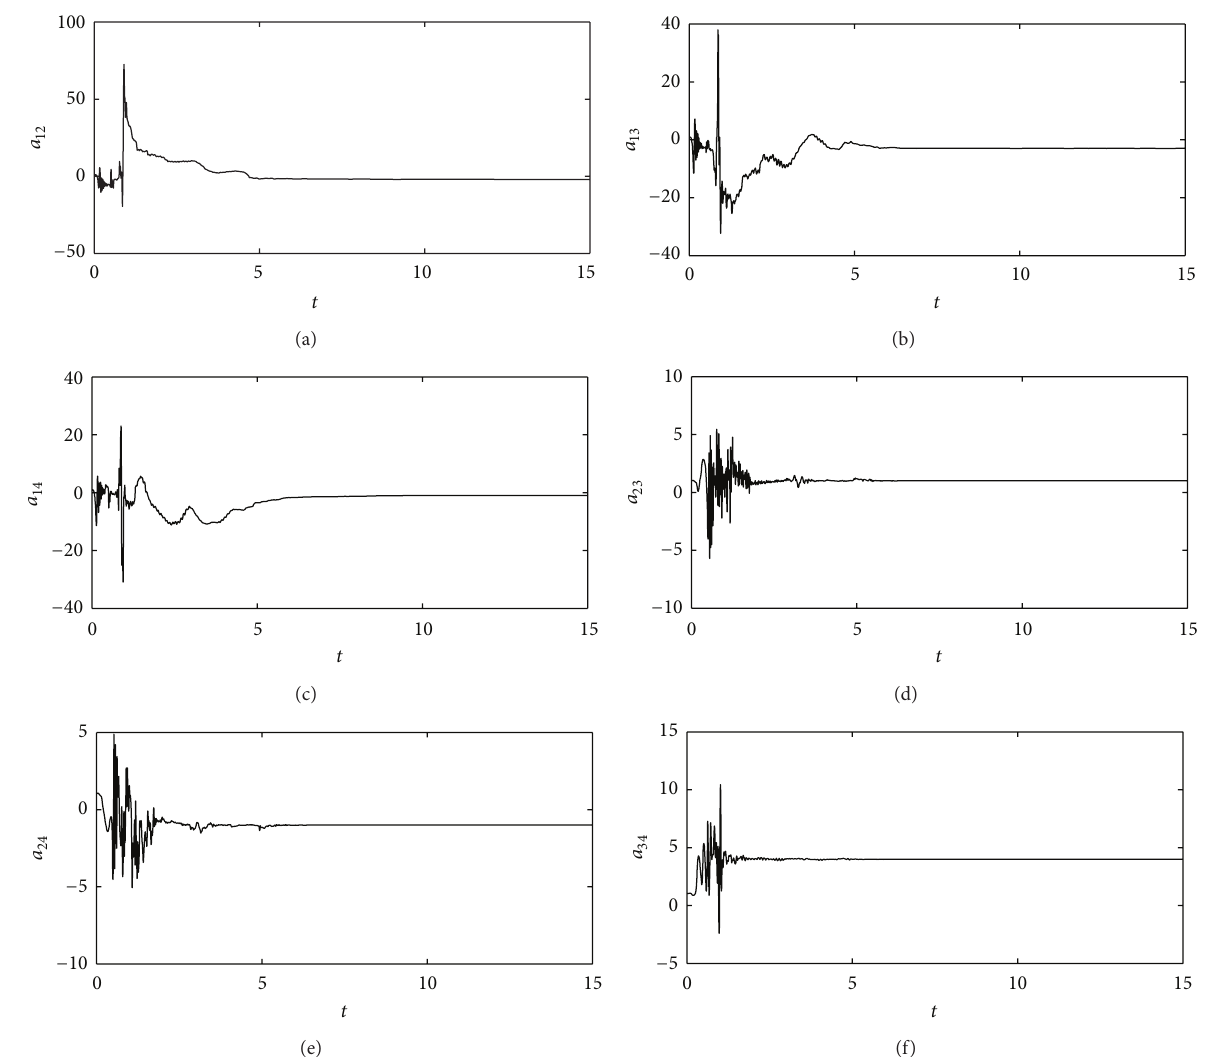
Figure 2: Identification of network structure (some elements of matrix